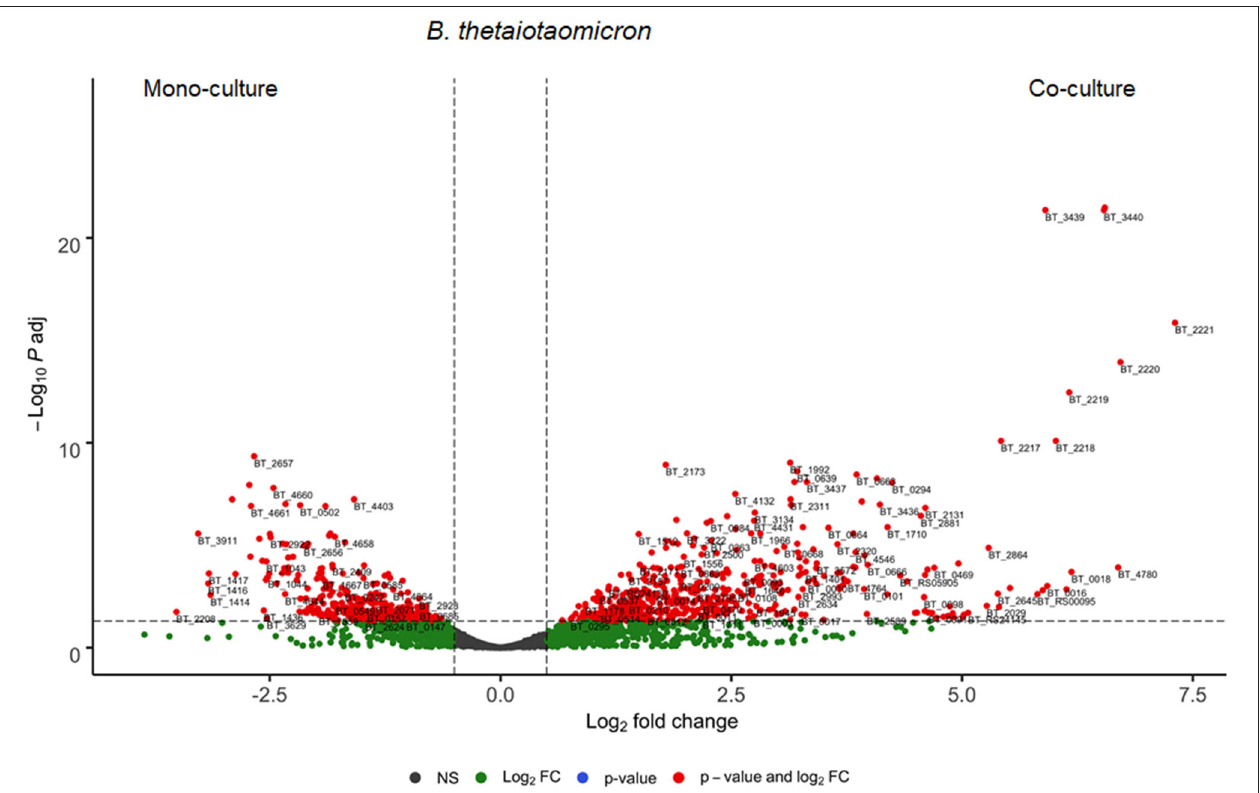
FIGURE 3 | Differential expressed genes of B. thetaiotaomicron between mono- and co-culture during in vitro fermentation. Volcano plot of the differential expressed B. thetaiotaomicron genes of mono- vs. co-culture. Positive Log2 fold change indicates upregulation in co-culture. The horizontal dashed black line adjusted p -value threshold ( q -value = 0.05). The vertical dashed black lines indicate Log2 fold change threshold (Log2 fold change =